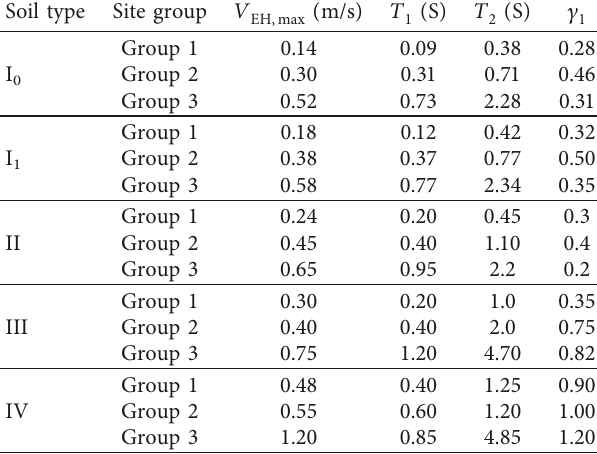
Table 1: Equivalent velocity spectrum parameters when the ac- celeration amplitude is 0.2g.